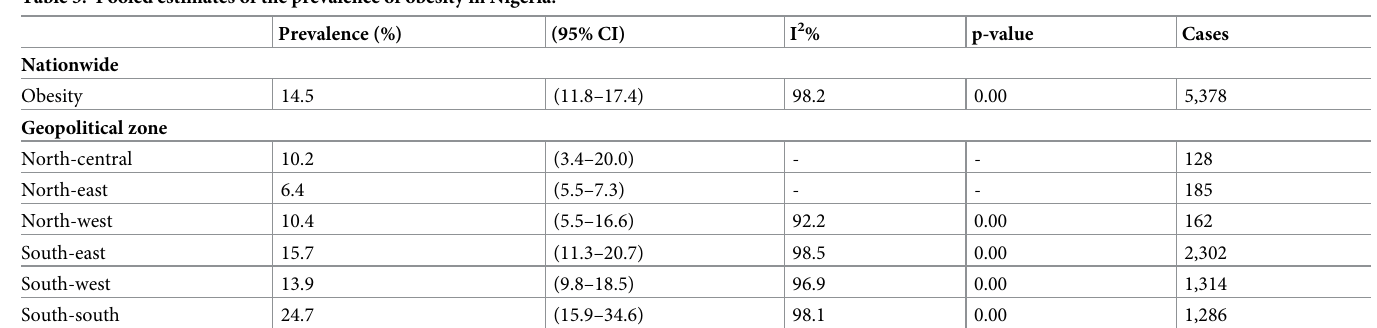
Table 3. Pooled estimates of the prevalence of obesity in Nigeria.